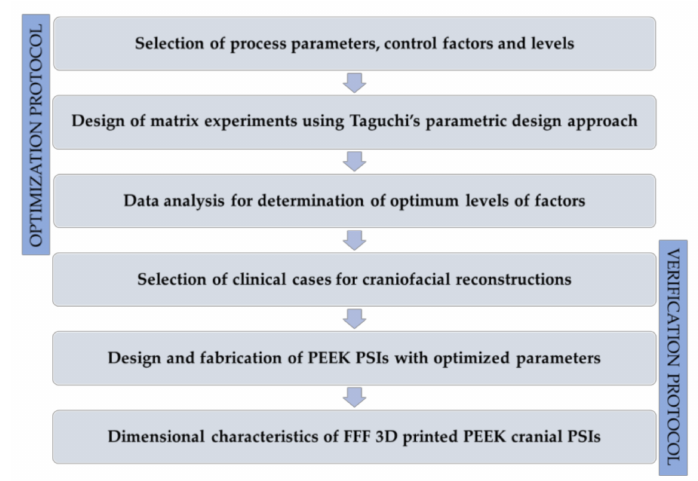
Figure 1. An overview of the schematic representation of the optimization and the verification protocols.